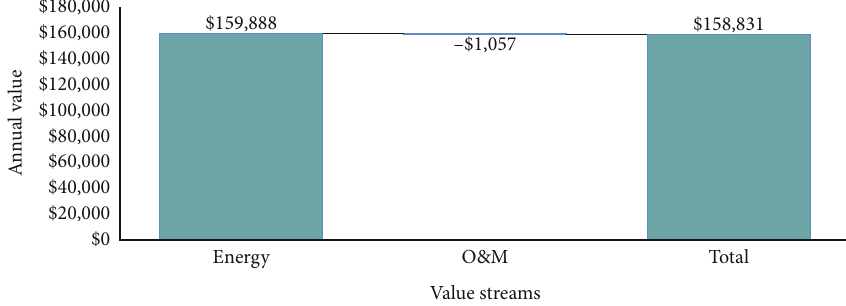
Figure 34: Categorized annual savings for the proposed system for Burundi.